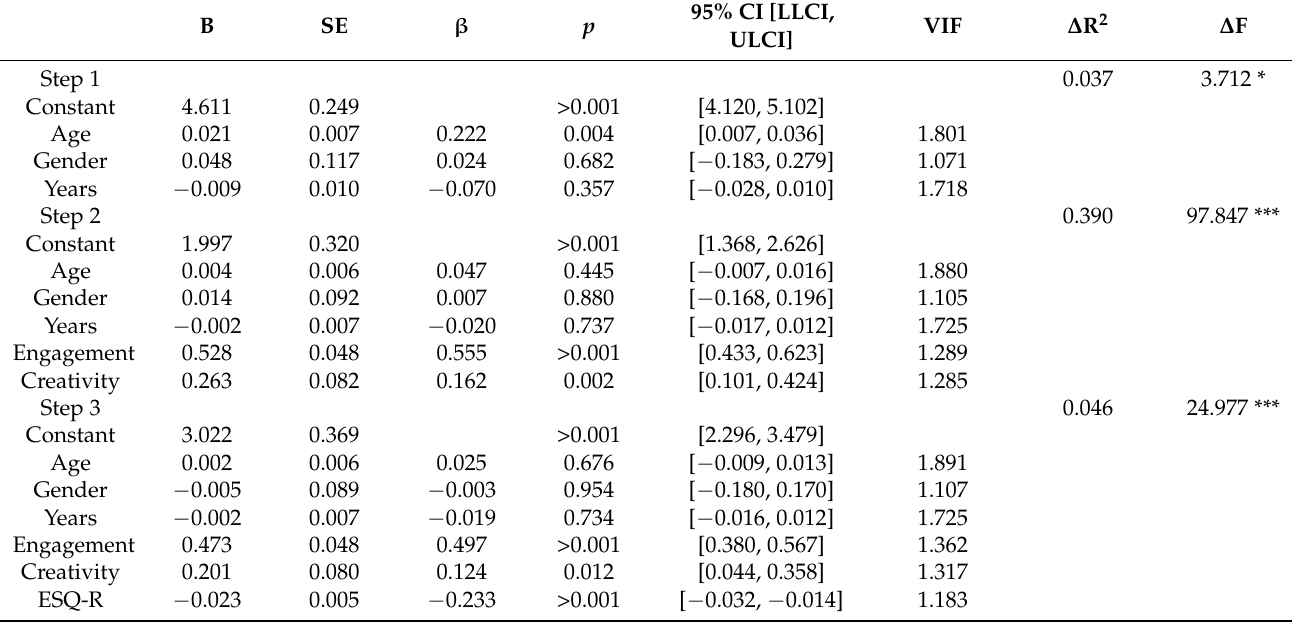
Table 4. Results of Hierarchical Multiple Regression Analysis for Executive